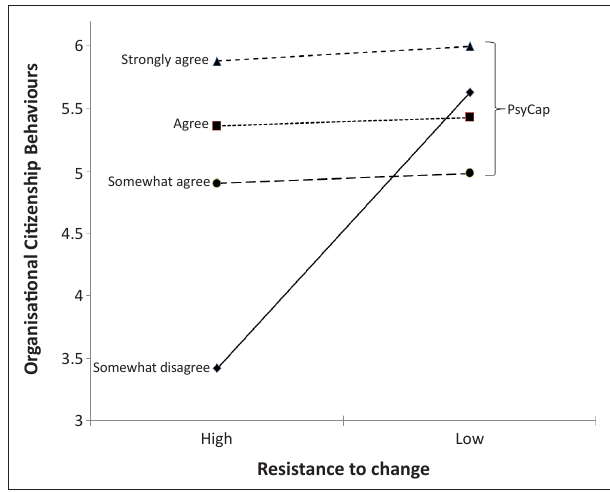
Resistance to FIGURE 2: Resistance to change moderating the positive effect of positive psychological capital on organisational citizenship behaviours.